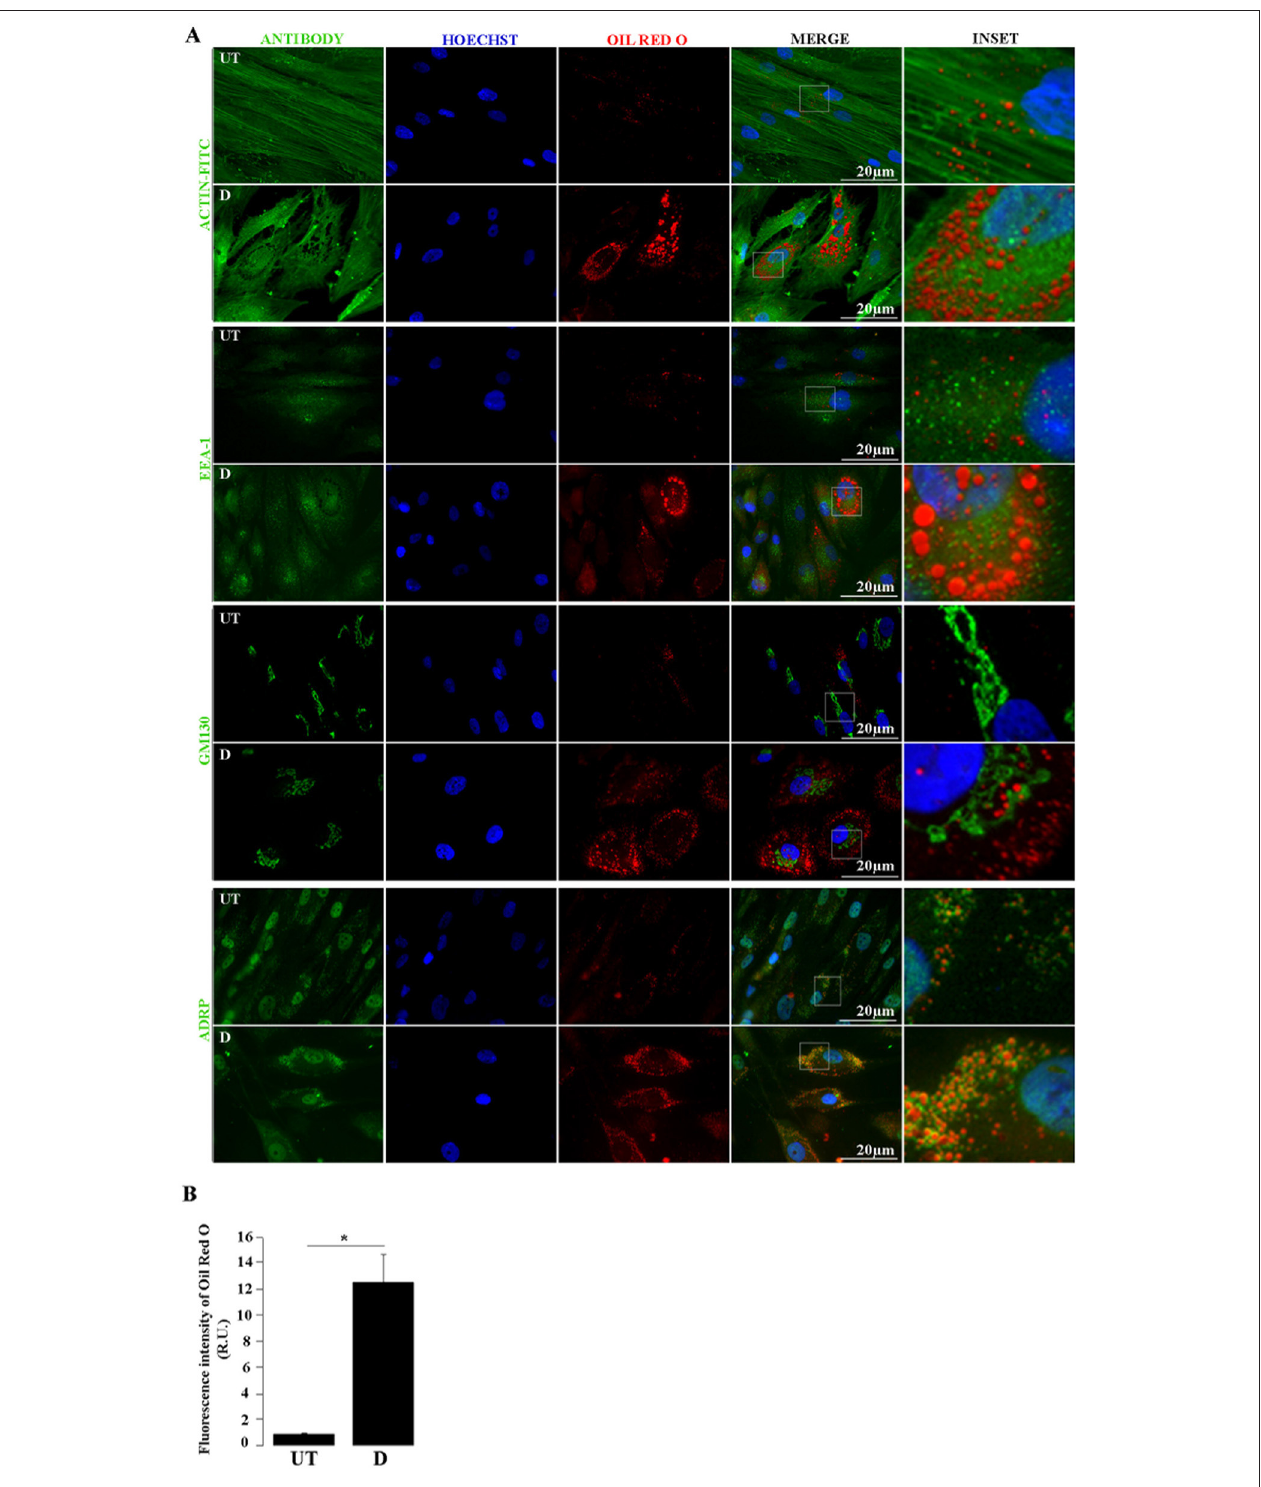
FIGURE 4 | Lipid droplets and cellular proteins double staining. (A) by Untreated (UT) and differentiated (D) hASCs were Oil Red O (ORO) and immunostained, and analyzed by fluorescence microscopy. Green signal corresponds to the indicated proteins detected by immunofluorescence (Actin-FITC) or indirect immunofluorescence (EEA-1, GM 130, ADRP); blue signal corresponds to Hoechst-stained nuclei; red signal corresponds to ORO-stained LDs. (B) Automated quantification of ORO fluorescence intensity relative units (R.U.) in UT and D hASCs. Bars represent mean values ( + /– standard deviation) from 14 ORO-stained images prepared as in A and normalized to the number of nuclei/image. The asterisk indicates significant differences between samples (Student’s test; p -value < 0.01). Data were similar in two other experiments.